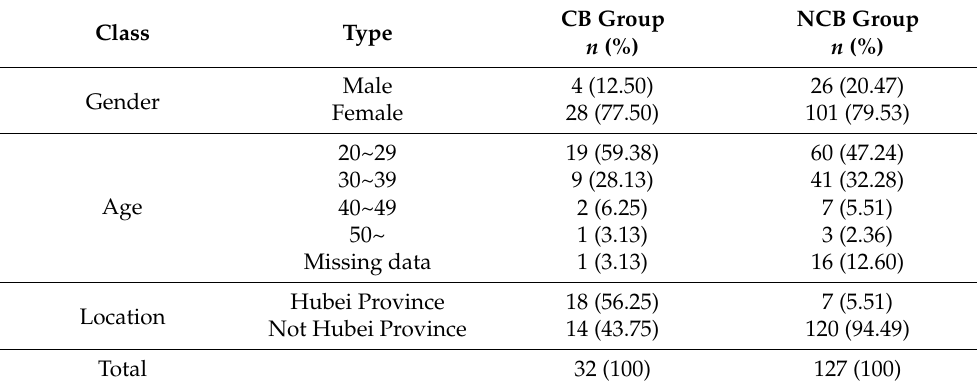
Table 1. Demographic profiles of bereavement users.